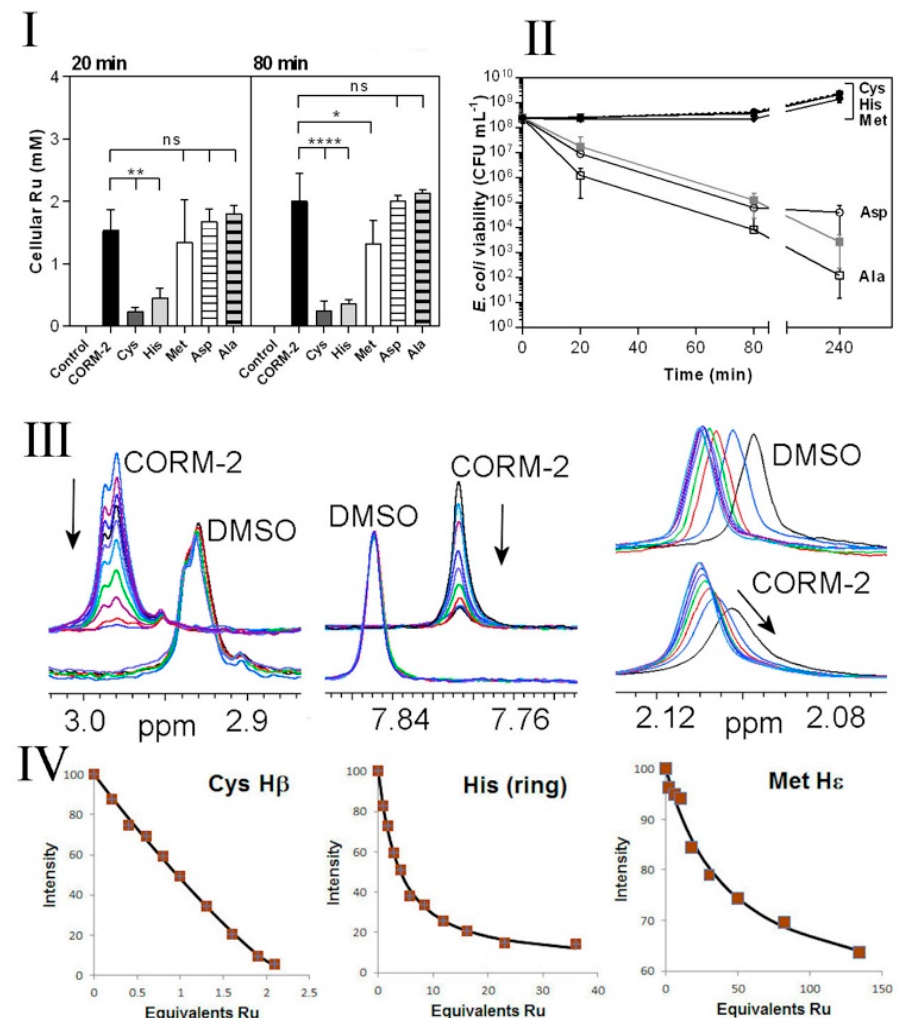
Figure 5. Extracellular amino acids protect E. coli against CORM-2, reduce Ru accumulation and in vitro have high affini- ties for CORM-2. I , II . Cys, His and, to a lesser extent, Met protect cells against CORM-2 toxicity and prevent intracellular Ru accumulation. CORM-2 stock solutions were incubated with a 2-fold excess of each amino acid prior to addition of CORM-2/amino acid mixtures (30 μ M CORM-2, final concentration) to cultures. Extracellular Cys and His significantly reduced the extent of CORM-induced intracellular Ru accumulation ( I ); Cys, His and Met exerted a dramatic reduction in CORM-2-induced cytotoxicity ( II ) (grey line) and restored viability to that of the control (dashed line) (* p ≤ 0.05, ** p ≤ 0.01, **** p ≤ 0.0001, assessed via unpaired t-test). Data in I and II represent 3 biological repeats, shown as mean ± SD. (III , IV ) Attenuation of toxicity correlates with CORM-2 binding affinities for synthetic peptides containing Cys, His or Met as assessed via 1 H NMR. The nature of the interactions between CORM-2 and these amino acids was assessed by 1 H NMR titrations of synthetic peptides (A 3 XA 3 ) with CORM-2 or solvent (10% d 6 -DMSO/90% D 2 O), where X = Cys (C), His (H) or Met (M). ( III left ) Overlaid 1 H NMR spectra of A 3 CA 3 (78.5 μ M), showing the Cys H β signal titrated with 0–82.4 μ M CORM-2 or equivalent volume of solvent. ( III middle ) Overlaid 1 H NMR spectra of A 3 HA 3 125 μ M showing the histidine imidazole ring protons titrated with 0–500 μ M CORM-2 or equivalent volume of solvent. ( III right ) Overlaid 1 H NMR spectra of A 3 MA 3 peptide (78.5 μ M) showing the Met H ε protons titrated with 0–4690 μ M CORM-2 or equivalent volume of solvent. In each titration the arrow shows the direction of increasing [CORM-2]. ( IV ) Binding curves of the decrease in intensity of 1 H NMR signals corresponding to Cys, His or Met (as shown in III ) upon increasing additions of CORM-2. The estimated K d of CORM-2 to each peptide was determined to be: 0.3 ± 1 μ M for Cys, 130 ± 25 μ M for His, 4700 ± 1000 μ M for Met. Titrations were performed in 30 mM KPi buffer pH 7.4 and pH was maintained by adjustment with KOH throughout the experiment.